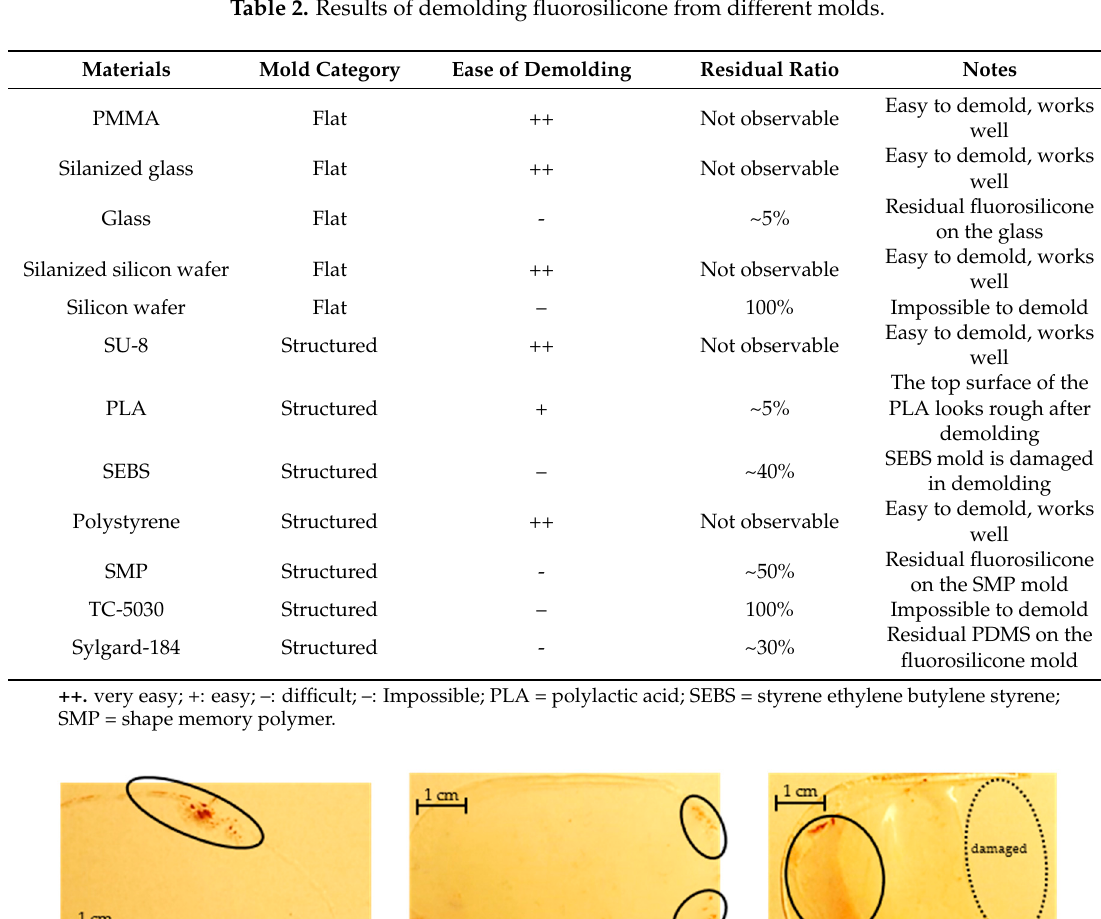
Table 2. Results of demolding fluorosilicone from different molds.